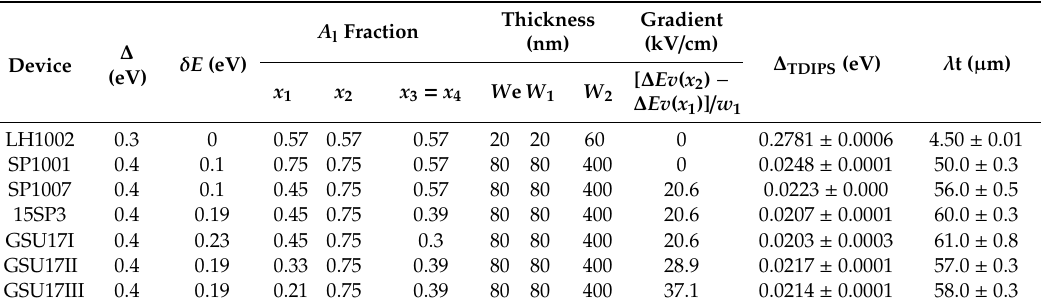
Table 1. Summary of results from the temperature-dependent internal photoemission spectroscopy (TDIPS) fitting method with corresponding device parameters (threshold wavelength is also